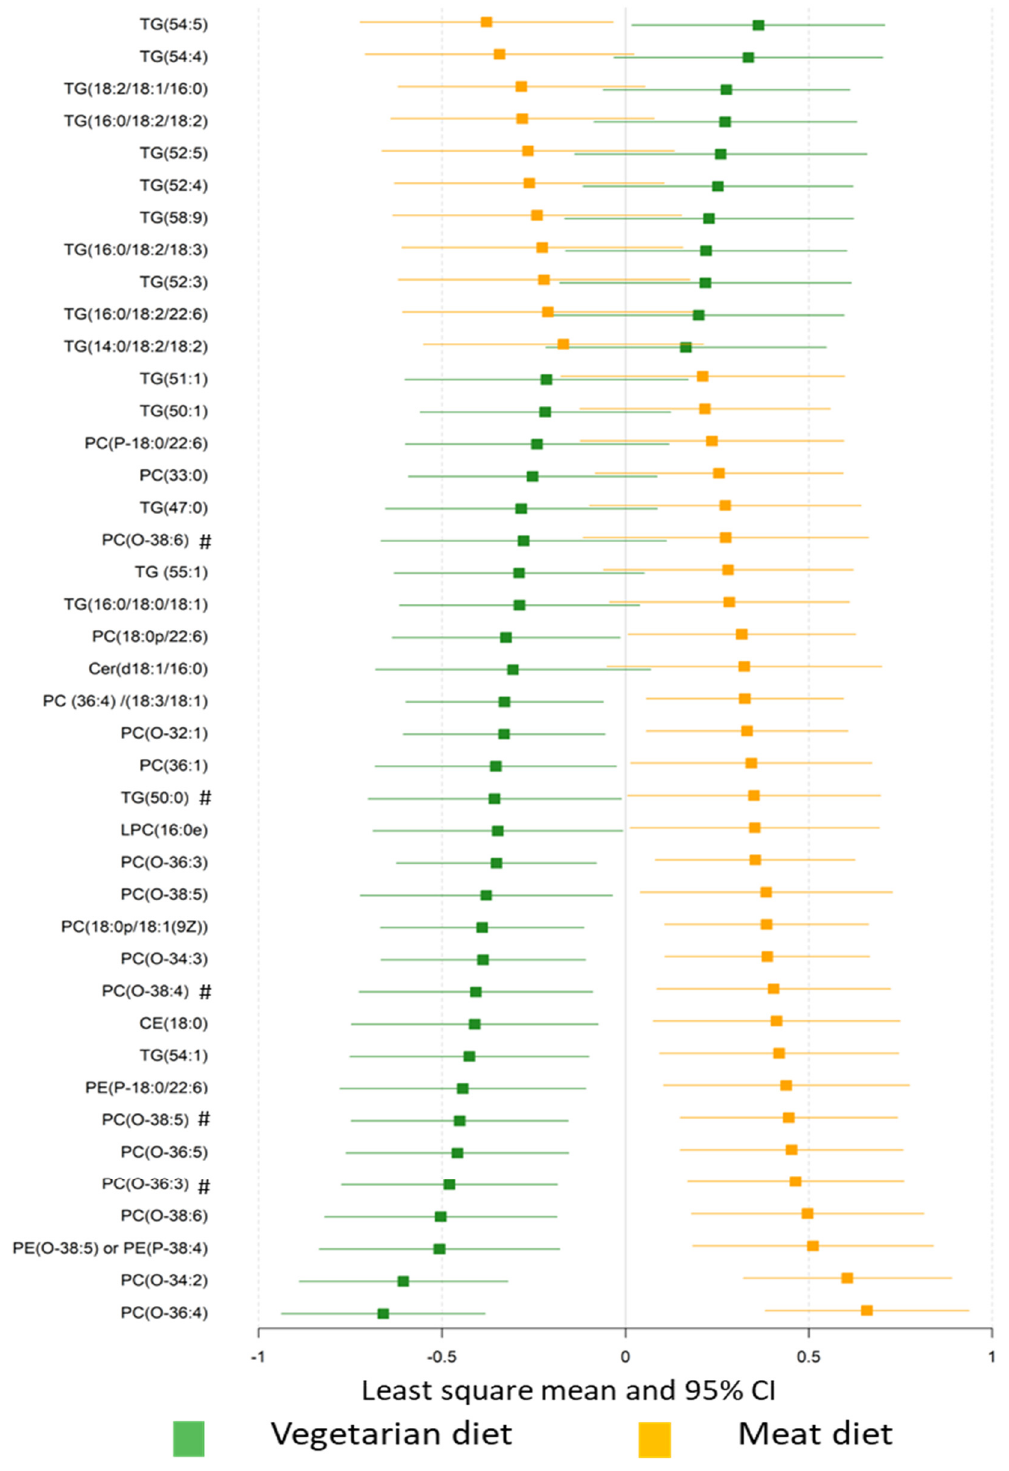
Figure 3. The effect of diet on plasma lipid profiles. Plasma lipids significantly differed between the vegetarian and meat diet by generalized linear mixed modelling (FDR p < 0.05). Standardized values of least-squares mean with 95% confidence intervals are presented for comparison. TG, triacylglycerols; DAG, diacylglyceride; PC, phosphatidylcholine; PG, phosphatidylglycerol; PI, phosphatidylinositol; PE, phosphatidylethanolamine; O-PC, alkylphosphatidylcholines; LPC, lyso- phosphatidylcholine; SM, sphingomyelin; Cer, ceramides; CE, cholesteryl ester. # Lipids with same fatty acyl chains (Cx:y) were presented in the dataset, where x represents the number of carbon atoms and y the number of double bonds of the fatty acyl chain.